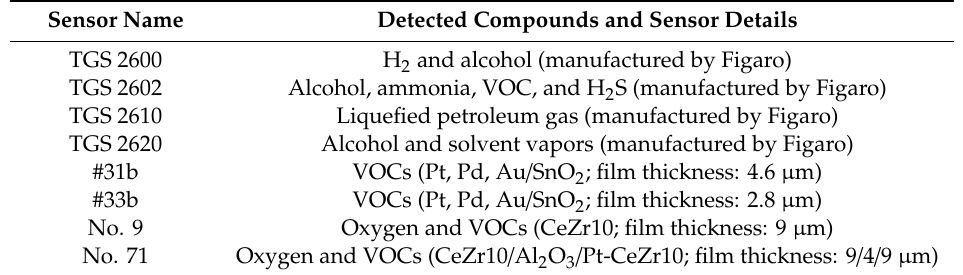
Table 1. Details of four TGS sensors; two Pt, Pd, Au / SnO 2 ; and two Zr-doped CeO 2 sensors used in this study. VOCs, volatile organic compounds.